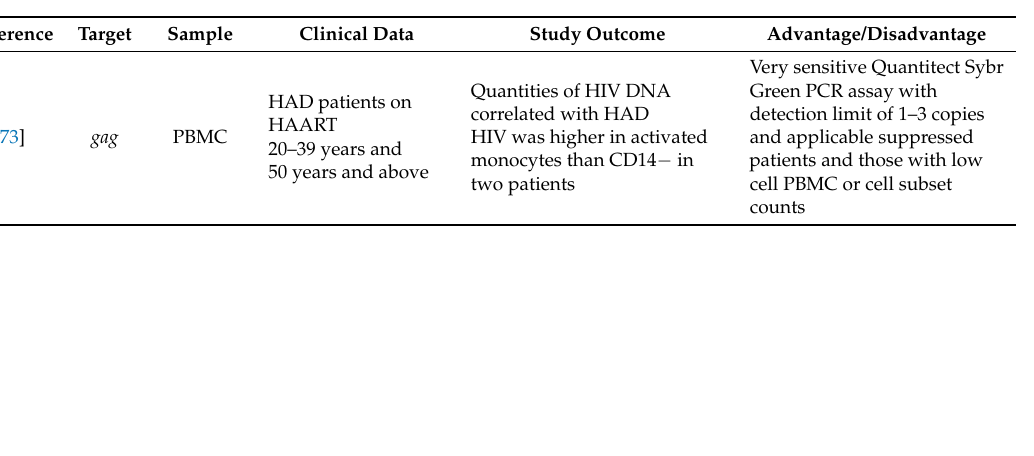
Table 2. HIV DNA real time PCR assays applied in HAND